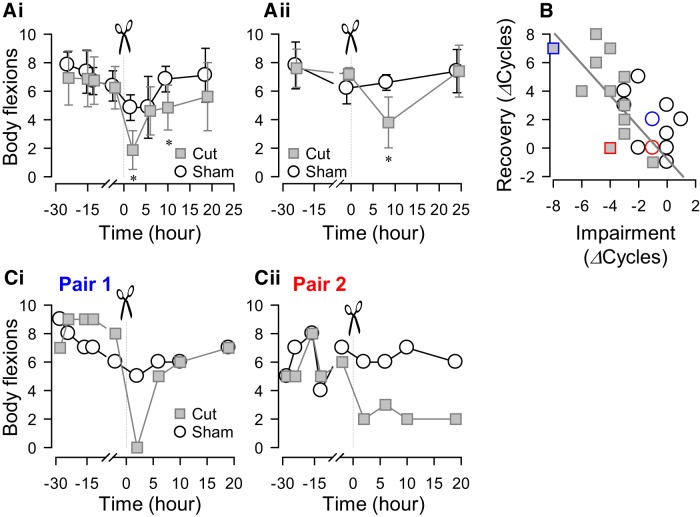
Individual variability in recovery of swimming after a lesion. A, Changes in the number of body flexions during the escape swim behavior for animals with PdN6 transected (gray squares) and sham-operated controls (white circles) measured over time. PdN6-transected animals were paired with sham-operated animals and tested in a blind fashion. In one set of experiments, the swim behavior was evoked four times (24, 15, 12, and 2 h) prior to the transection and four times (2, 6, 10, and 19 h) after the transection (N = 8 for both cut and sham; Ai). In the other set, the swim was evoked twice (24 and 1 h) prior to the transection and twice (8 and 24 h) after the transection (N = 4 for both cut and sham; Aii). A two-way repeated-measures ANOVA was conducted for each graph to test statistical significance between transected and sham animals. For both intervals, there was no statistical significance between transected and sham animals (Ai: F(1,93) = 3.24, p = 0.09; Aii: F(1,24) = 1.48, p = 0.26). However, pairwise multiple comparison procedures (Holm–Sidak method) revealed a significant difference (*) between sham and tested animals at 2 and 10 h in Ai (p = 0.002 and 0.04, respectively), and at 8 h in Aii (p = 0.003). B, The increase in the number of body flexions upon recovery showed a significant correlation, with the decrease caused by PdN6 disconnection (impairment) in test animals (gray squares; R
2 = 0.46, p = 0.01 by Pearson product moment correlation, N = 13), but not in sham animals (open circles; p = 0.09 by Pearson product moment correlation, N = 13). Blue and red symbols correspond to the examples in C (blue, pair 1; red, pair 2). C, Two examples (pair 1 and pair 2) showing different effects on the number of body flexions during the escape swim behavior for animals in response to PdN6 transection (gray squares) compared with sham-operated controls (white circles). In one example, cutting PdN6 caused a large decrease in the number of body flexions compared with sham, which was followed by recovery (pair 1, Ci). In the other example, the decreased number of body flexions did not recover after 20 h (pair 2, Cii).